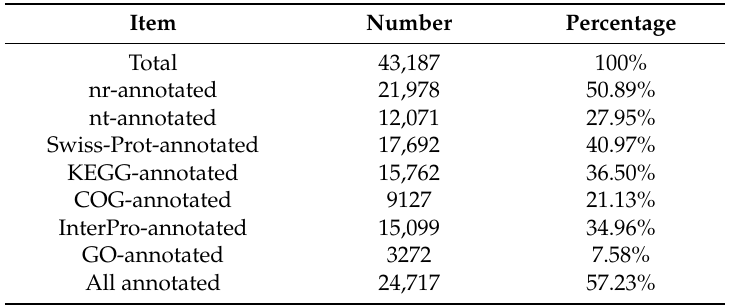
Figure 3. Categories of genes classified based on the Kyoto Encyclopedia of Genes and Genomes (KEGG) analysis. Table 1. Functional annotations of the Xenocatantops brachycerus